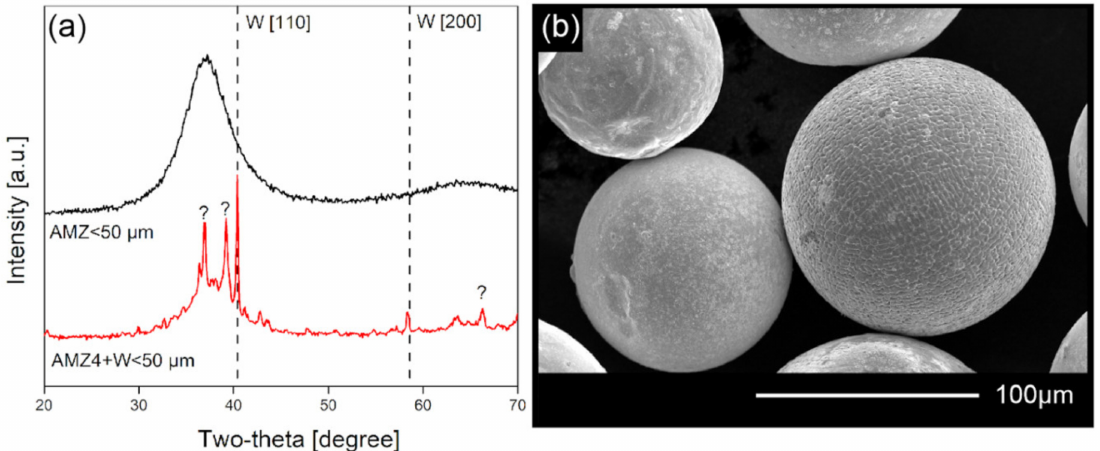
Figure 5. X-ray diffractogram for AMZ4 and AMZ4 + W < 50 µ m particles ( a ) and the SEM image of 50–100 µ m AMZ4 particles ( b ).